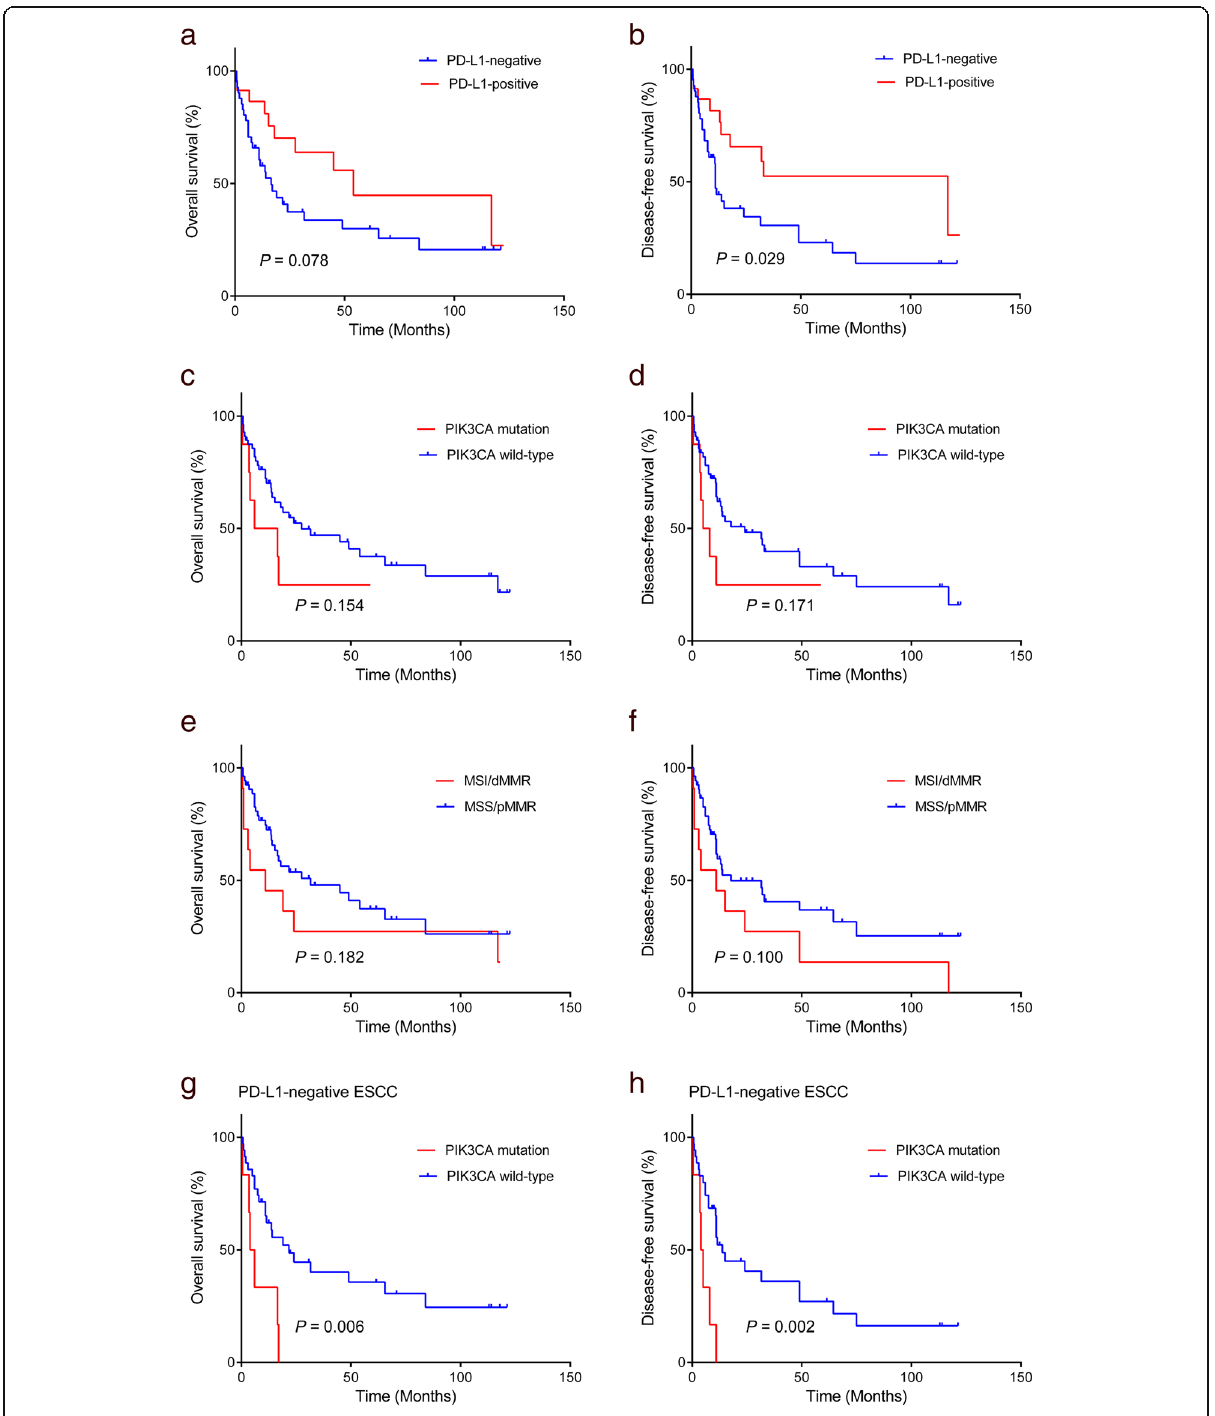
Fig. 3 Kaplan – Meier survival curves according to PD-L1 expression ( a , b ), PIK3CA mutation ( c , d ), MSI/dMMR ( e , f ) for overall survival and disease-free